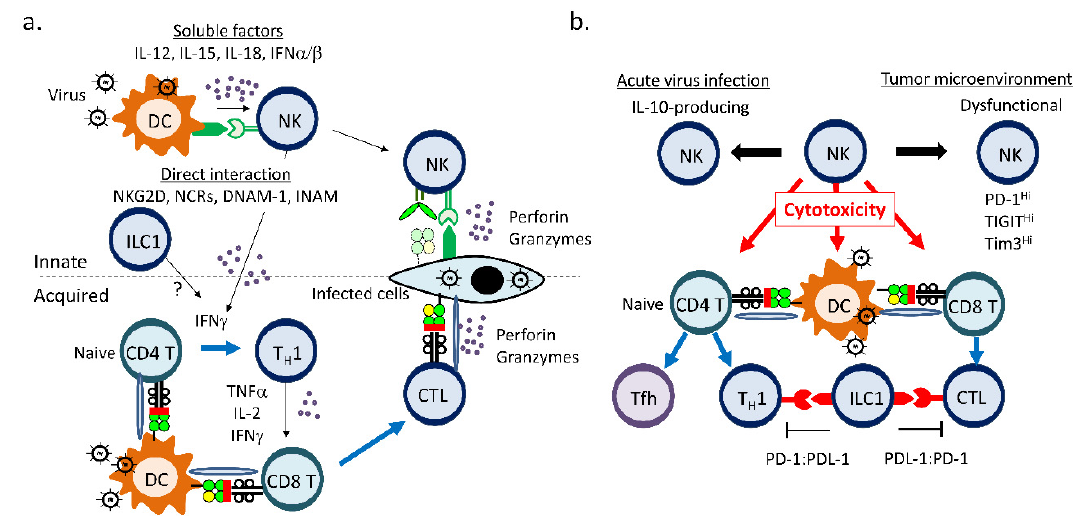
Figure 2. Natural-killer (NK) cells and ILC1s positively or negatively regulate acquired immunity. ( a ) NK cells enhance Type I immunity mediated by T H 1 cells. NK cells are highly activated after mutual interaction with dendritic cells (DCs) that sense pathogen-associated pattern molecules (PAMPs) such as virus-derived RNAs and DNAs. Activated NK cells secrete IFN- γ for T H 1 skewing. ( b ) NK cells and ILC1s suppress antivirus acquired immunity. NK cells attack CD4 + T cells, CD8 + T cells, and infected-DCs to inhibit acquired immune responses against virus infection. PDL-1 on hepatic ILC1s suppresses anti-virus CD4 + and CD8 + T cells through PD-1 on T cells. IL-10-producing NK cells and dysfunctional NK cells may be involved in suppressing cytotoxic T lymphocyte (CTL) responses.